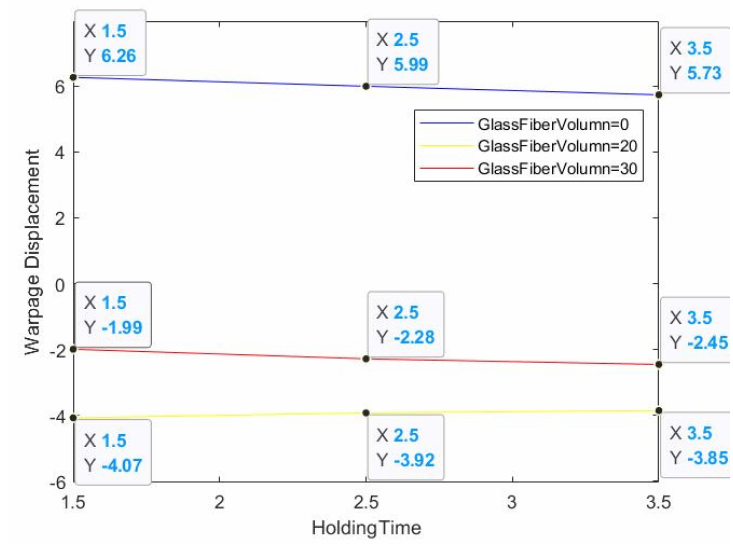
Figure 5. Warpage displacement with glass fiber and holding.